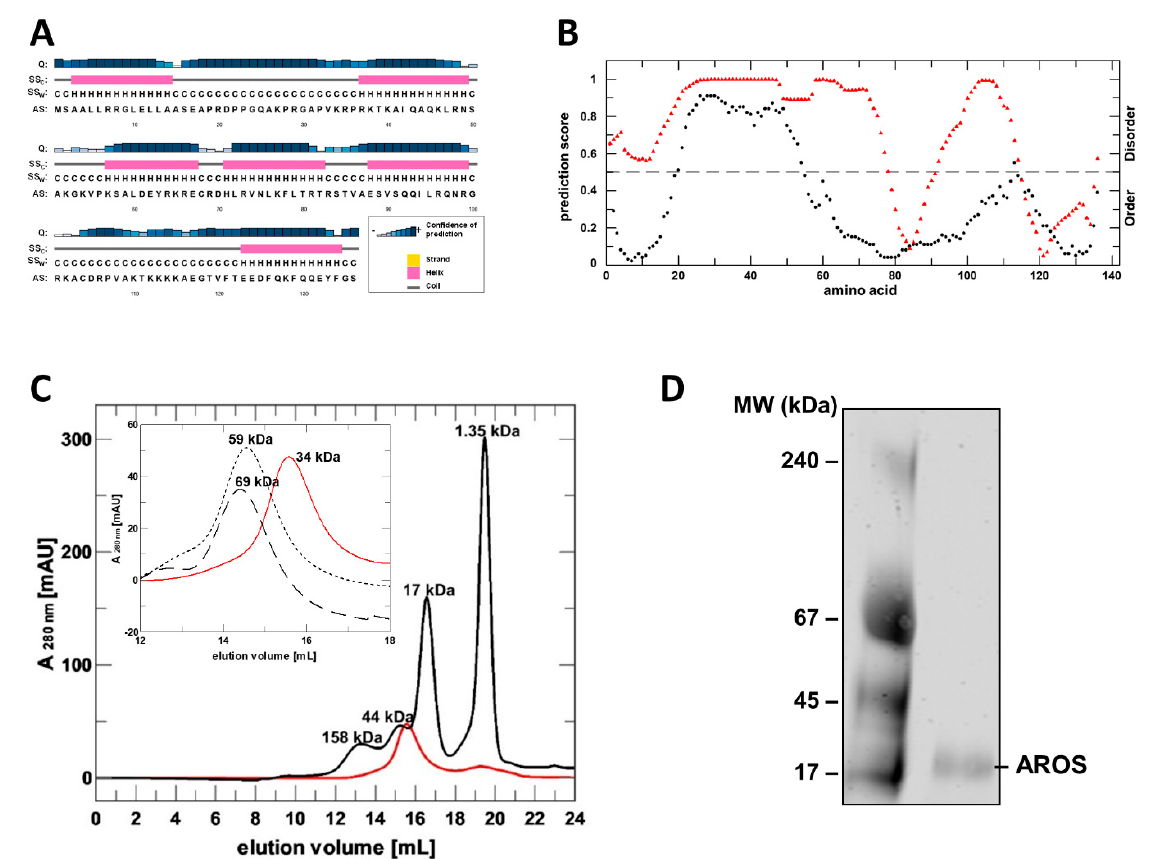
Figure 1. Sequence analysis, recombinant preparation and folding analysis of AROS protein. ( A ) Prediction of AROS secondary structure elements with PSIPRED (H/pink: α -helix; C/grey: coil). Confidence of prediction: blue (high), white (low). ( B ) Disorder prediction for human AROS using DISOPRED (black) and PONDR (red). ( C ) SEC elution profile of purified, refolded AROS (red) and of globular standard proteins (black; MW indicated). Inset: comparison of AROS elution profiles without additive (red) and with 4 M urea (dotted line) or 4 M GdnHCl (dashed line). MW values from comparison to standard proteins are indicated. ( D ) Blue native PAGE of refolded, purified AROS.